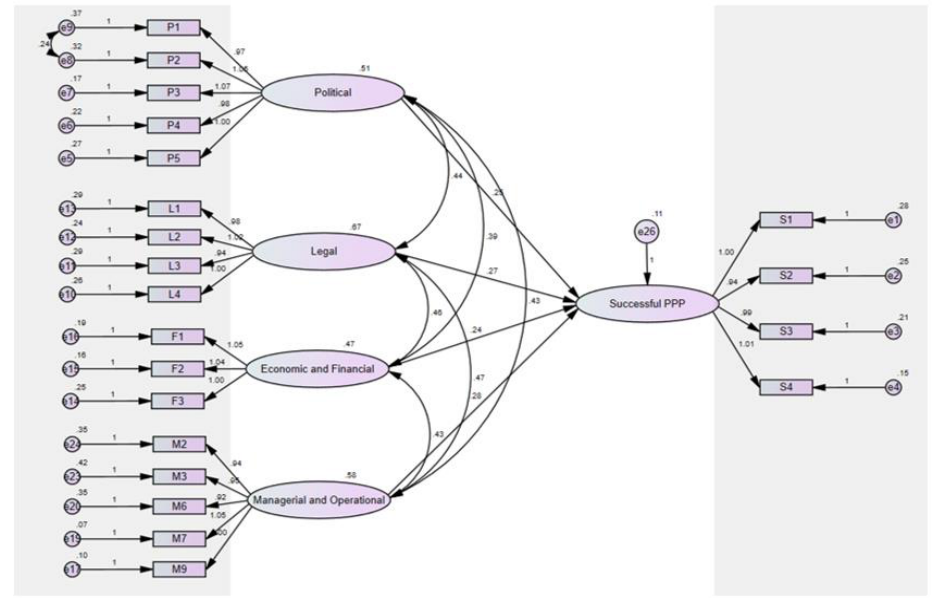
Figure 3. SEM model.